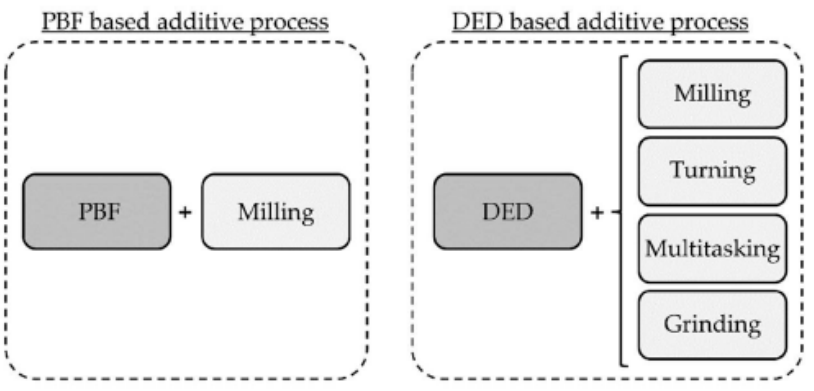
Figure 9. Different combinations of processes that can be performed using hybrid manufacturing, with powder bed fusion (PBF) or directed energy deposition (DED). Reproduced from [100]. MDPI Open Access Information and Policy: https://www.mdpi.com/openaccess; Accessed on 21 October 2022.